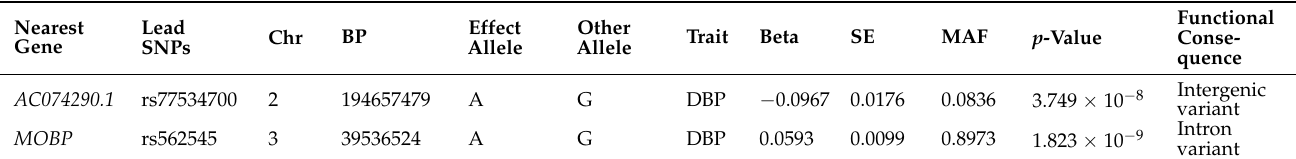
Table 2. Novel distinct variants identified using a meta-analysis approach.